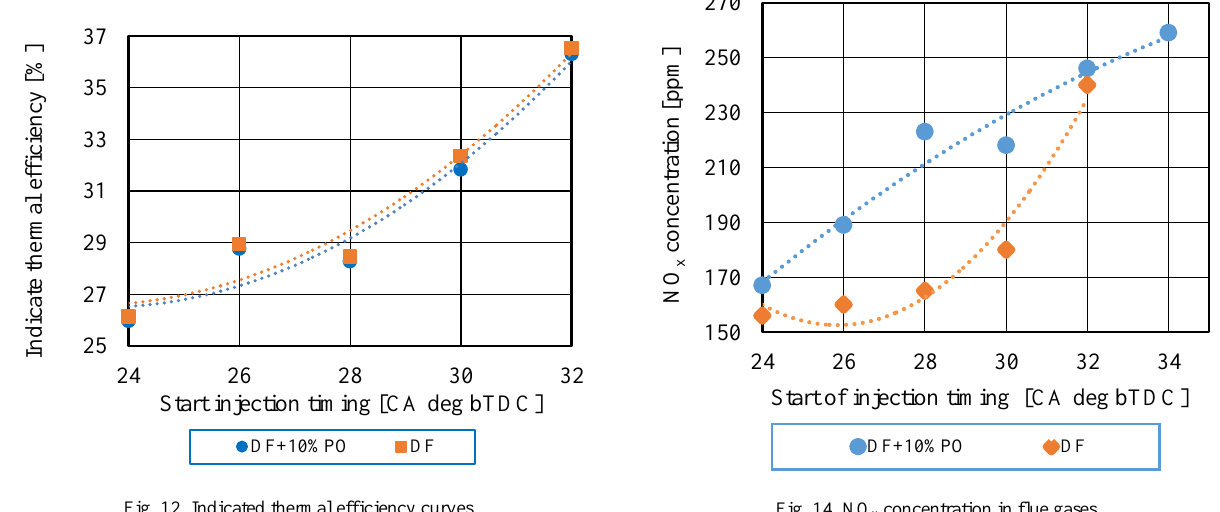
Fig. 14. NO x concentration in flue